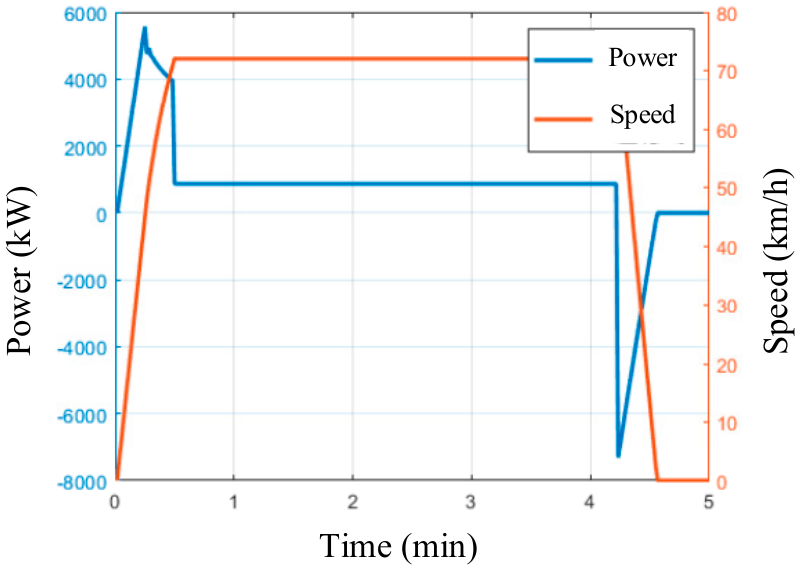
Figure 10. Dynamic change characteristics of train power.